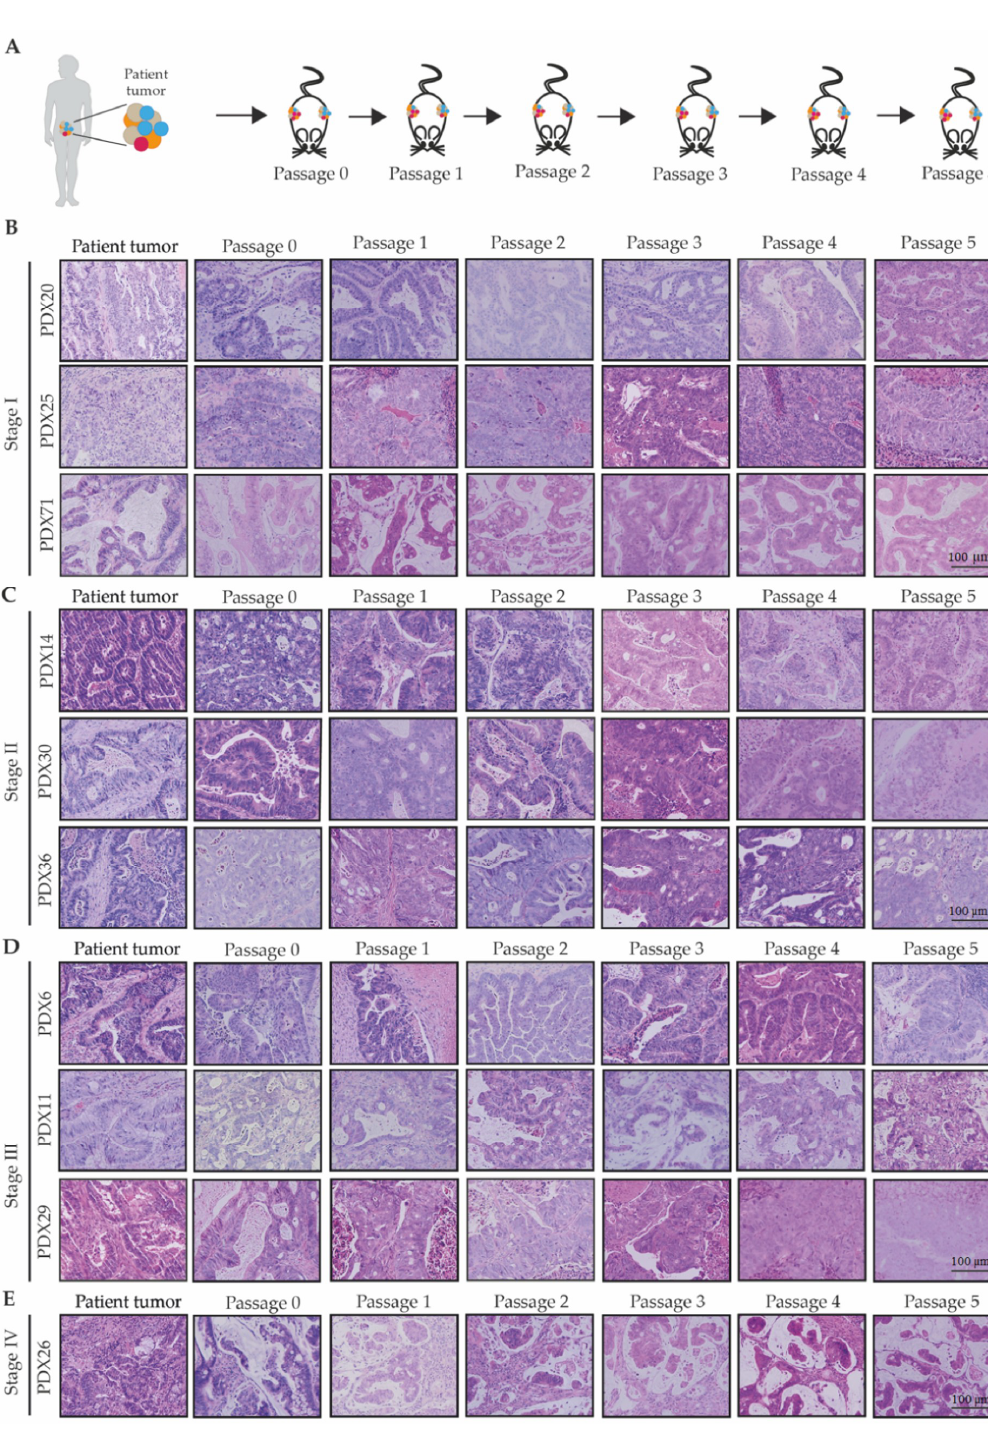
Figure 2. Histological characterization of CRC patient-derived xenografts. ( A ) Schematic representation of the passaging of PDXs; ( B – E ) representative Haematoxylin & Eosin (H&E) images of xenograft tumors from each passage. Each of the PDX lines are separated by stage: ( B ) Stage I, ( C ) Stage II, ( D ) Stage III, and ( E ) Stage IV. Scale bar for B–D is 100 µm and applies to all images.